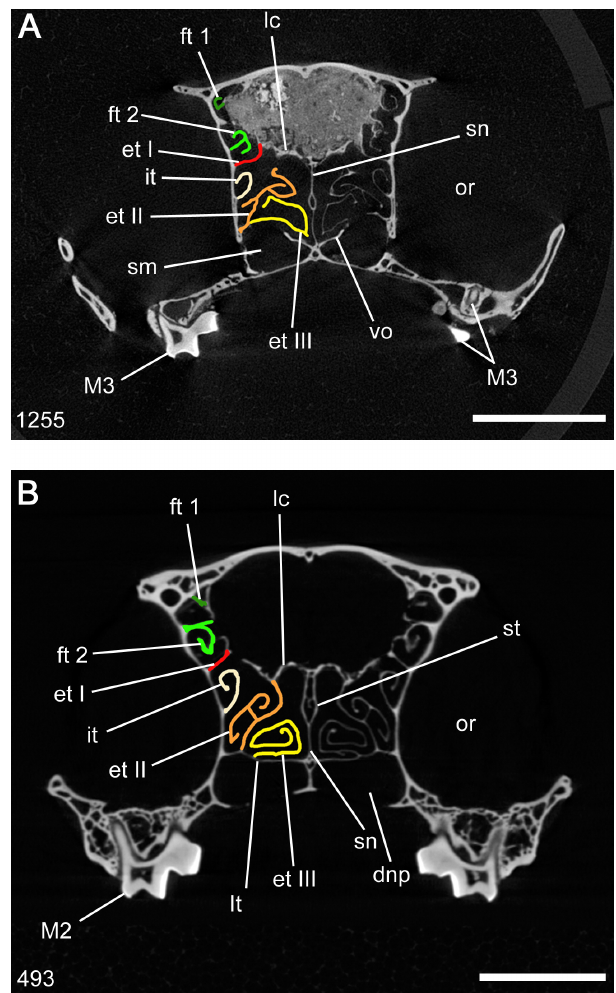
Figure 12. µCT cross-section images of the pars posterior of the adult rostrum from anterior to posterior of (a) Ptilocercus lowii (ZMB 3992) and (b) Tupaia sp. (collection W. Maier). Numbers in figures refer to number of original µCT slices. Abbreviations: dnp, ductus nasopharyngeus; et I, II, III, ethmoturbinal I, II, III; ft 1, 2, frontoturbinal 1, 2; it, interturbinal; lc, lamina cribrosa; M2, 3, up- per molar 2, 3; or, orbit; sm, sinus maxillaris; sn, septum nasi; st, septoturbinal; vo, vomer. Scale bars equal